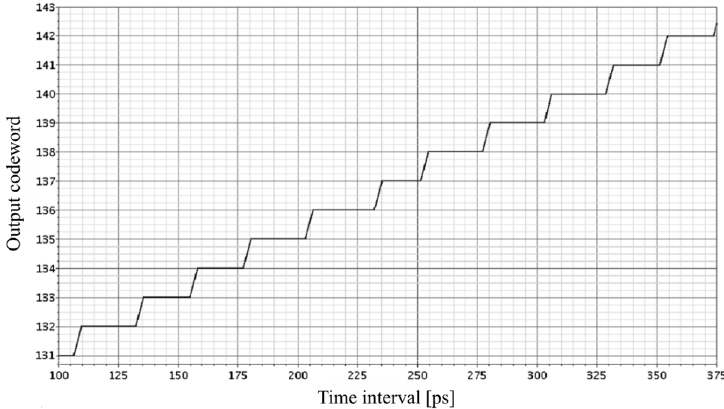
Figure 37. Transfer characteristics of 8-bit SA-TDC with symmetrized multiplexers for T 0 = 25 ps and T m = 250 ps.